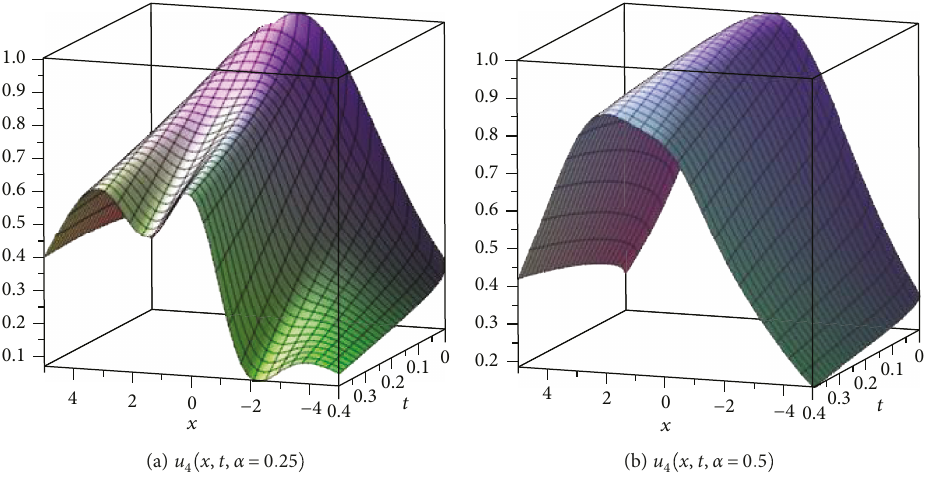
, t , α = 0 25,0 5 . 4 x